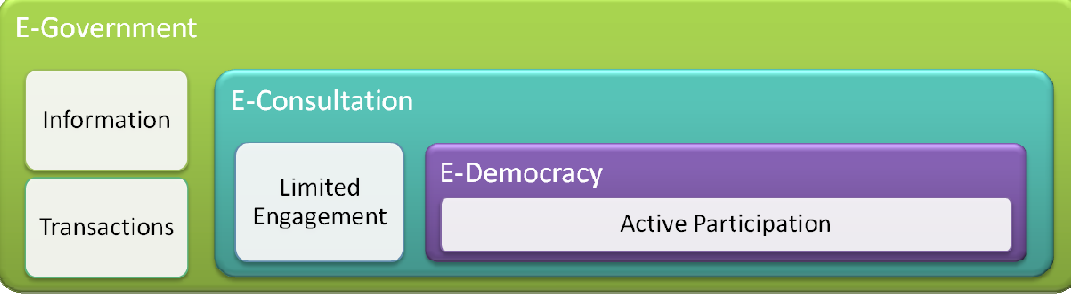
Figure 1: Forms of government-led